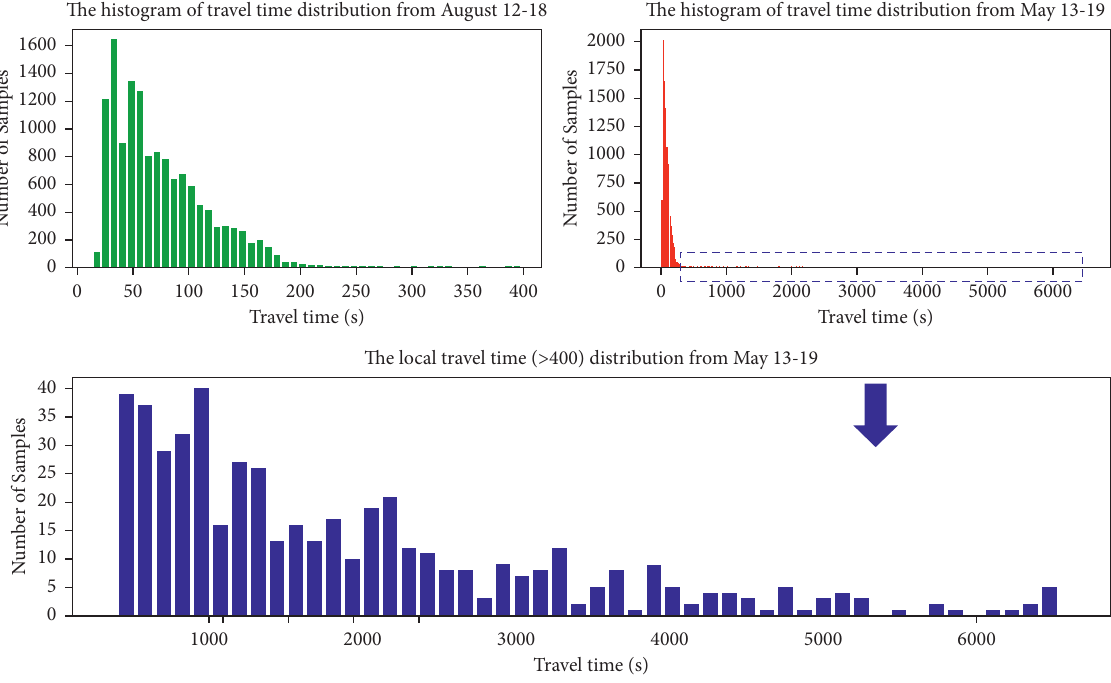
Figure 10: The comparison of travel time distributions on different